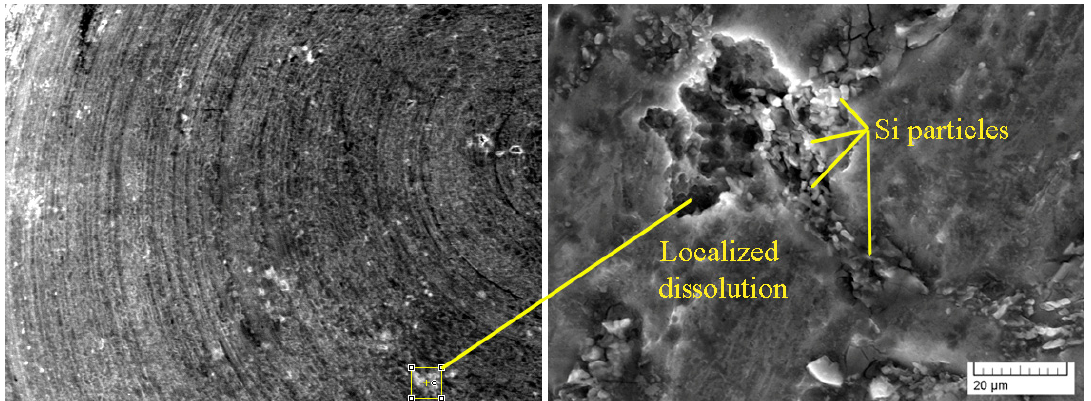
Figure 5. SEM observation of a corrosion attack on samples of alloy B after testing.